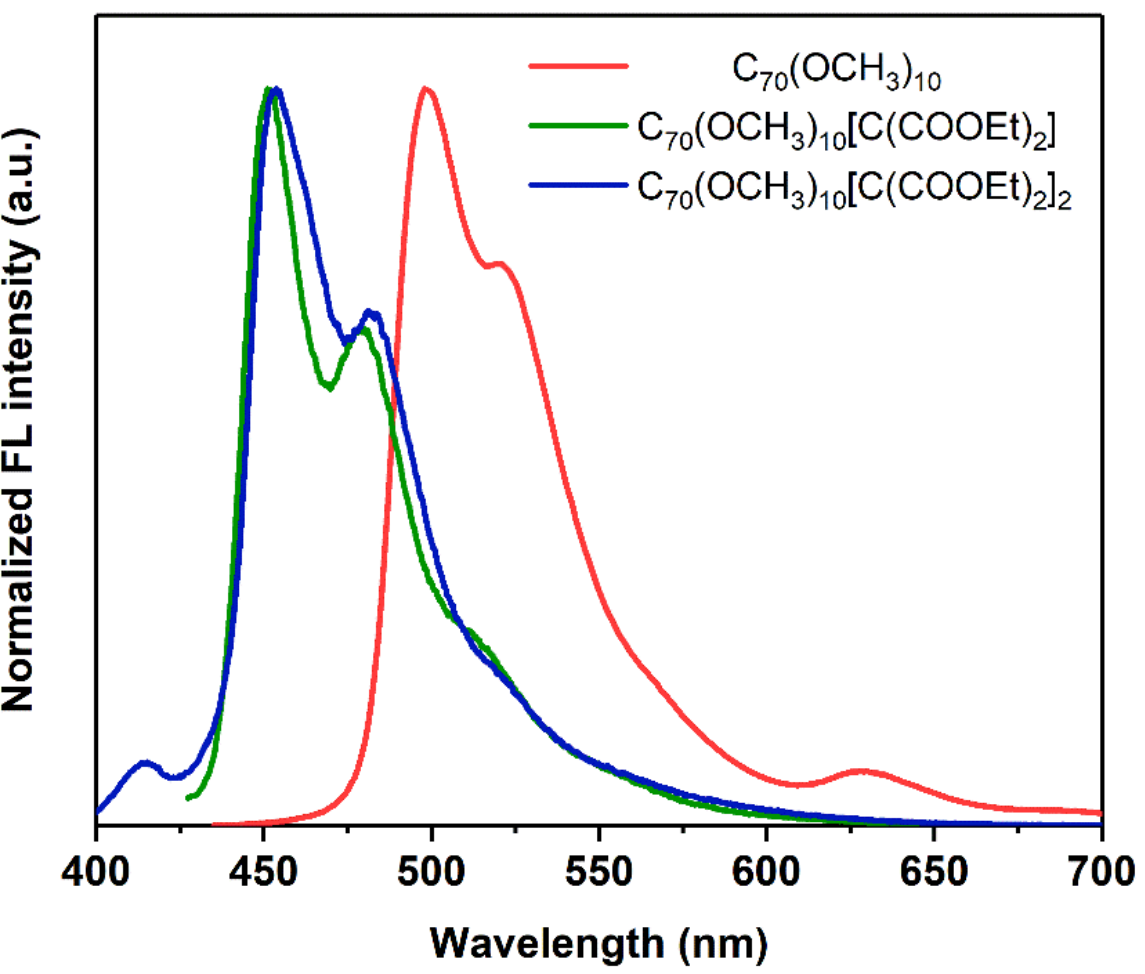
Figure 3. Normalized steady-state fluorescence spectra of C 70 (OCH 3 ) 10 , C 70 (OCH 3 ) 10 [C(COOEt) 2 ], and C 70 (OCH 3 ) 10 [C(COOEt) 2 ] 2 at room temperature.